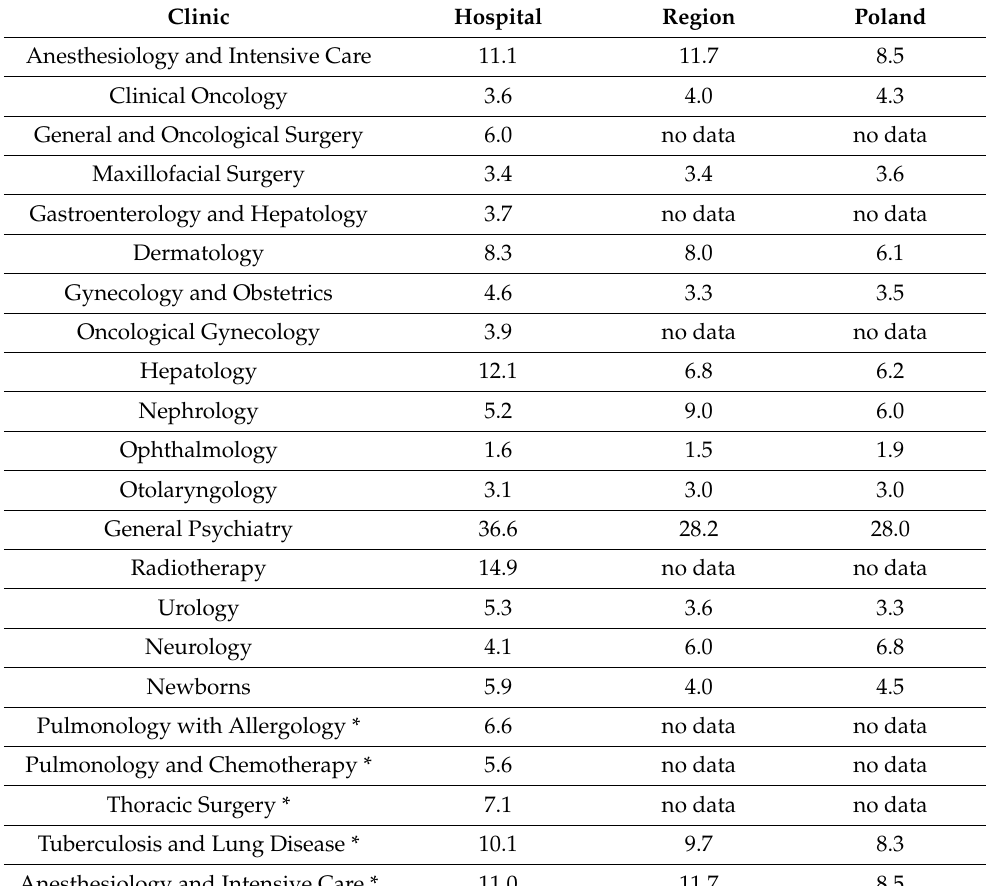
Table 4. The average length of stay of a patient in the clinics of the analyzed hospital, compared to the data for the Podkarpackie voivodeship and Poland in general (comparison for